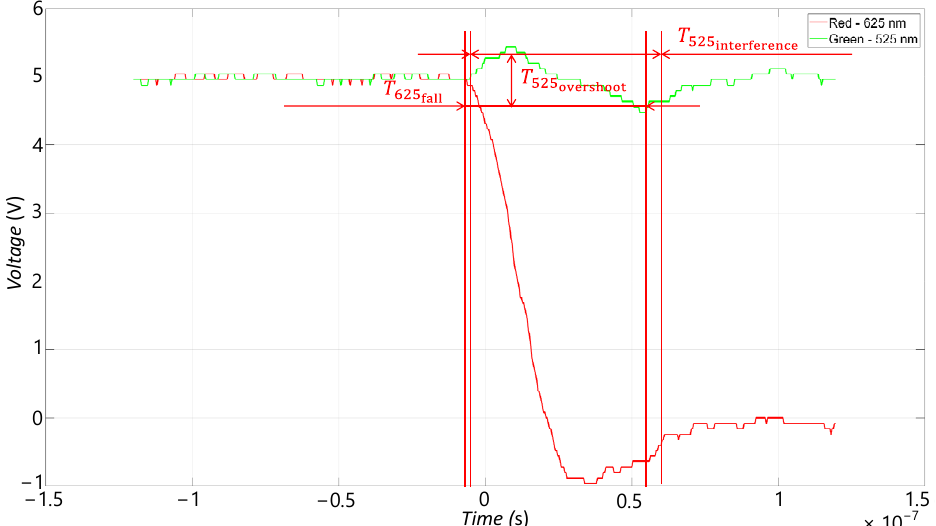
Figure 16. Recorded transients when the LEDs with a wavelength of 625 nm were switched on and the LEDs with a wavelength of 525 nm remained switched off.